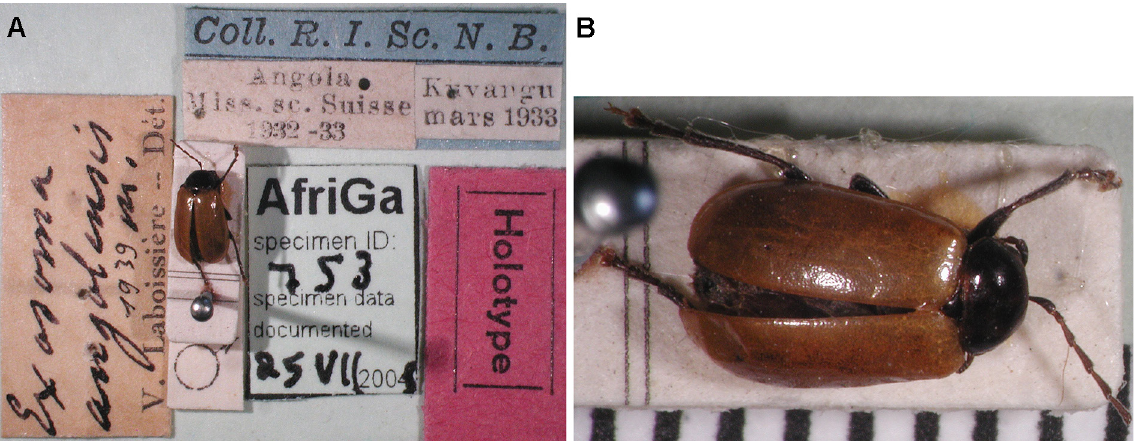
Fig. 9. Holotype of Oosagitta angolensis comb. nov. A . Overview with labels. B . Close-up of